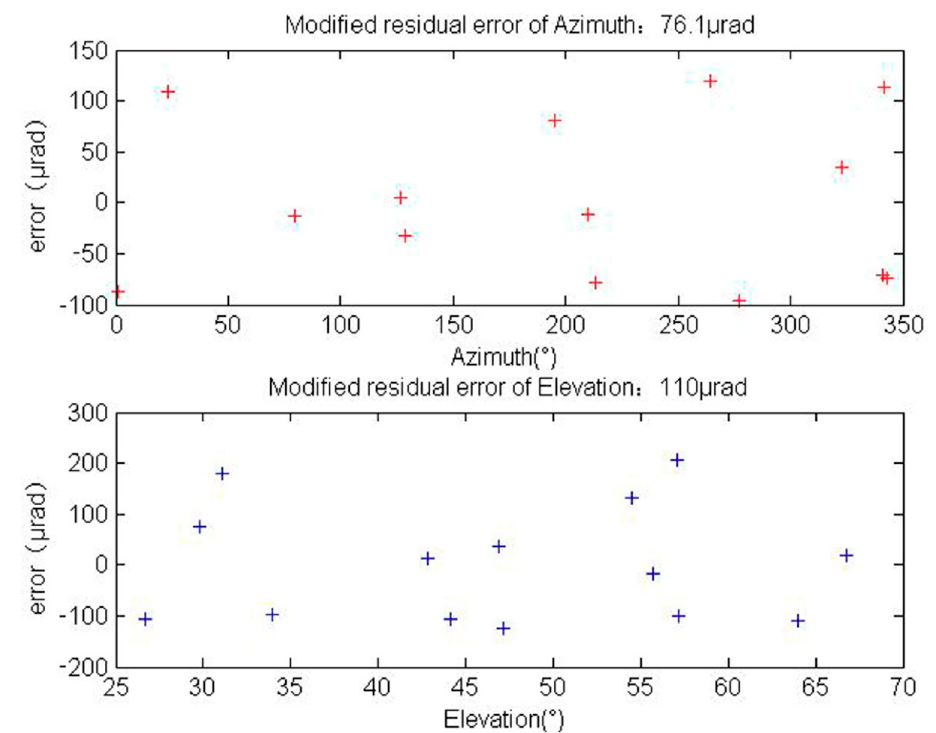
Figure 8. Residual error after systematic error correction. The azimuth residual error was obtained as 76.1 μ rad while the elevation residual error was110 μ rad.